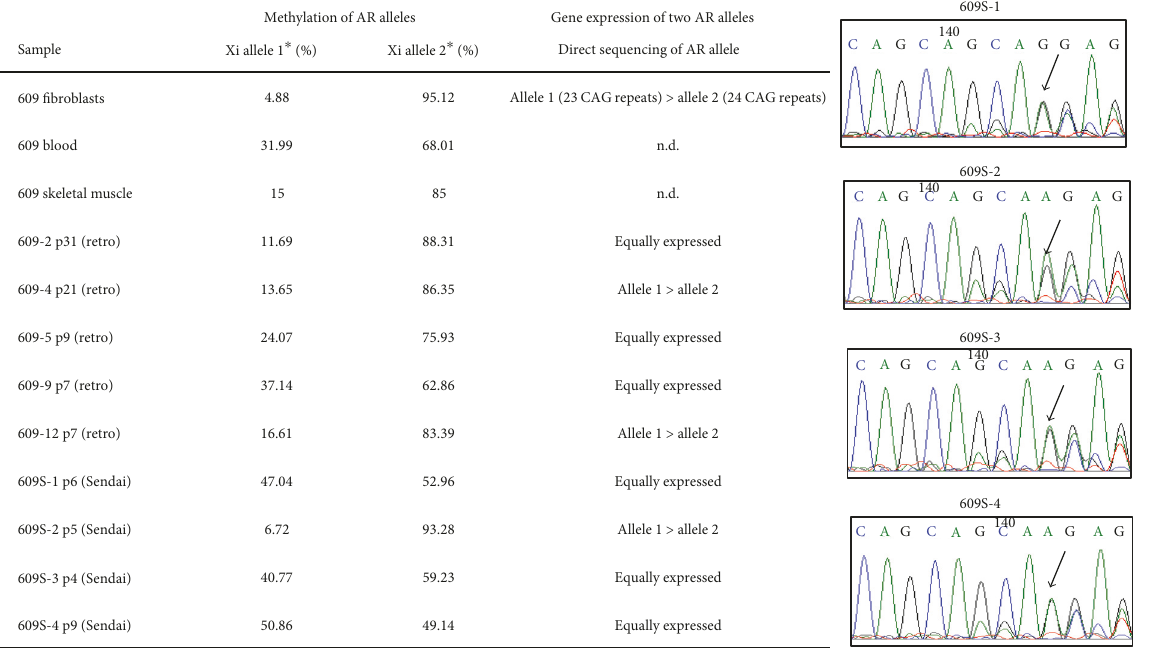
Figure 3: Methylation status and allele-speci fi c expression of androgen receptor (AR) gene in the fi broblasts, skeletal muscle, and blood sample of a manifesting carrier of DMD (609) and derived iPS cells. Left panel : ∗ % is calculated based on the assumption that one of two alleles is methylated, and signal intensities from allele 1+allele 2 are shown as 100%. However, not all iPS clones have XCI. Right panel : representative images of direct sequencing of the AR